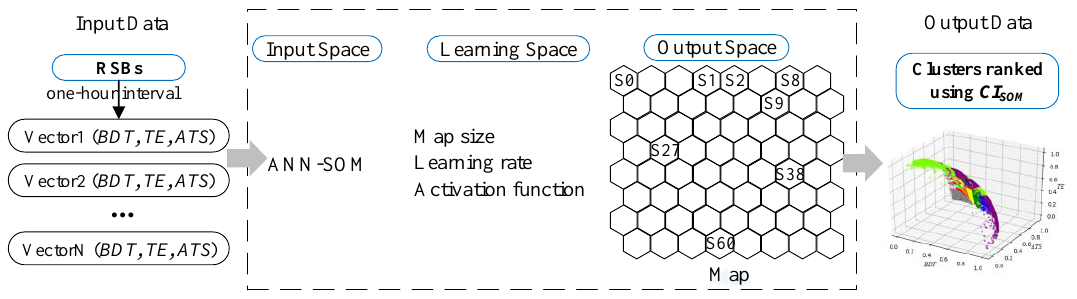
Figure 3. Flowchart of the self-organizing map used in this study.